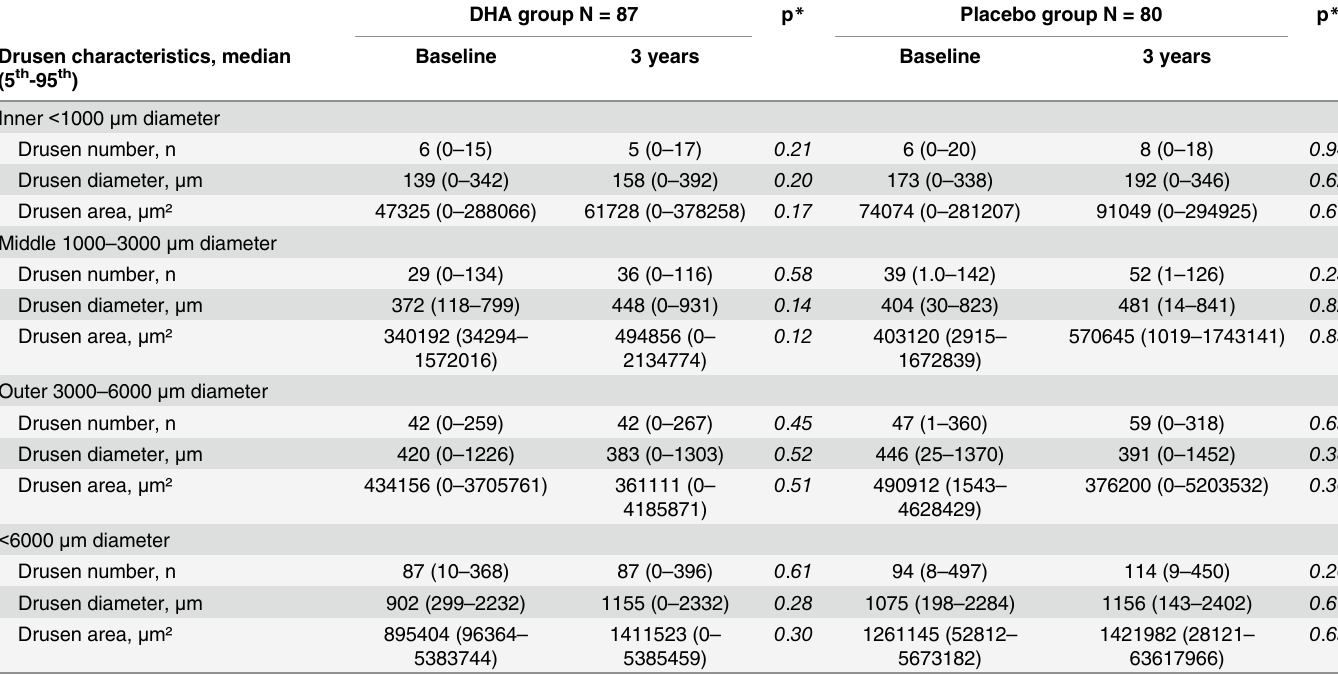
Table 2. Comparison of drusen characteristics between baseline and 3 years according to treatment group. DHA group N = 87 p * Placebo group N = 80 p